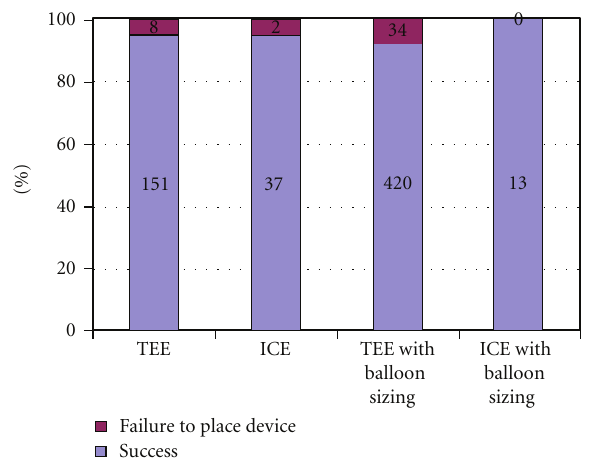
Figure 4: Failure ratio of transcatheter closure of ASD with TEE, ICE, and balloon sizing with TEE and balloon sizing with ICE ( n = 665). P value =